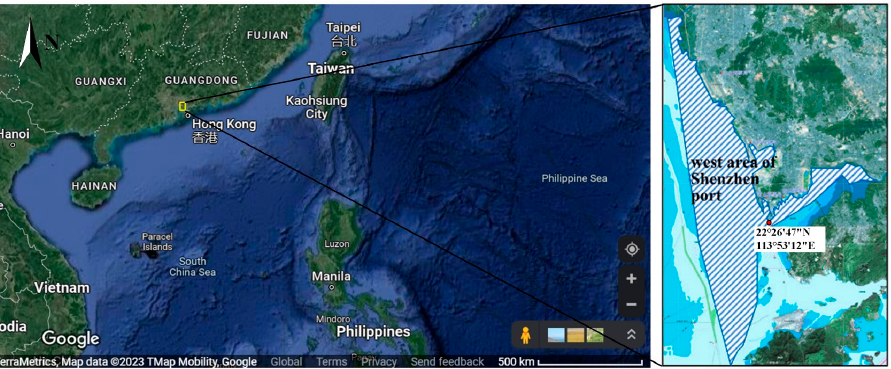
Figure 4. The west area of Shenzhen Port.